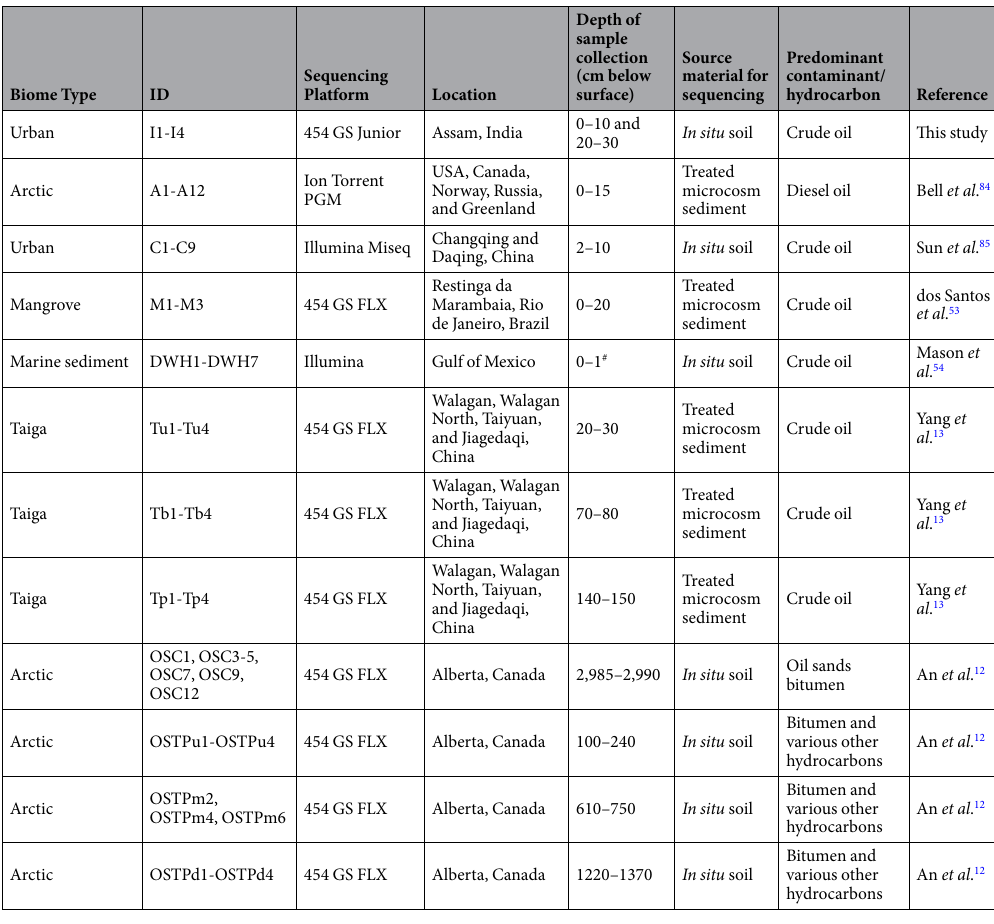
Table 1. Summary of datasets used in the study. (For additional details, refer to Supplementary Data Table S1). # All samples collected at an average of ~1500 metres below sea level, depth given is from the surface of the ocean